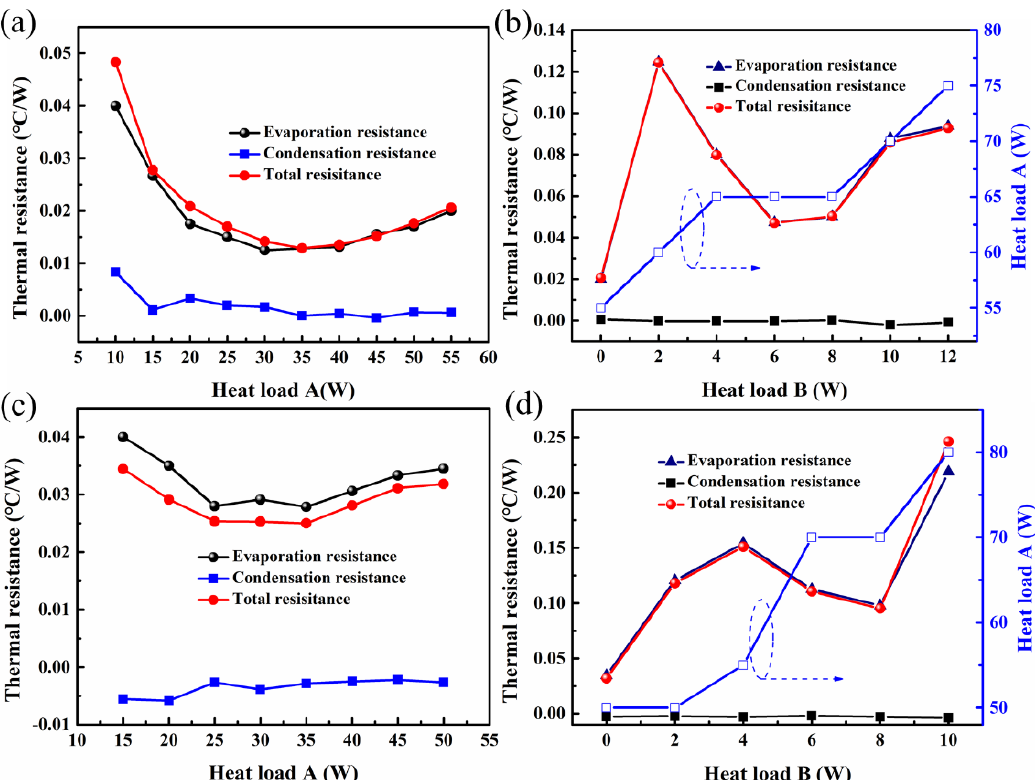
Figure 9. ( a ) The thermal resistance of TSHP − 1 with different heat load A from 10 W to 55 W; ( b ) the thermal resistance of TSHP − 1 with different heat load B from 0 to 12 W under a certain heat load A input of 45 W; ( c ) the thermal resistance of TGHP − 1 with different heat load A from 15 W to 50 W; ( d ) the thermal resistance of TGHP − 1 with different heat load B from 0 to 10 W.